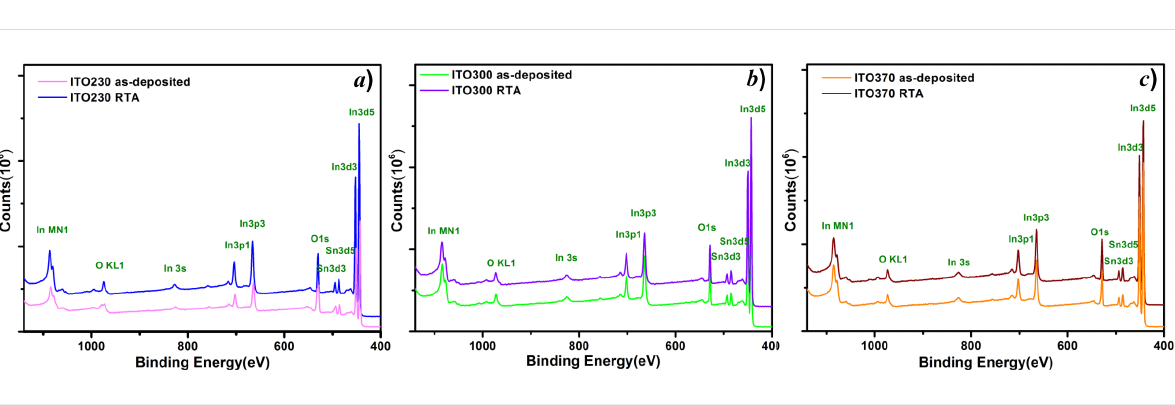
Figure 3: XPS survey spectra in the range 0–1250 eV acquired from the as-deposited and RTA-treated ITO samples of thickness a) 230 nm, b) 300 nm, and c) 370 nm.